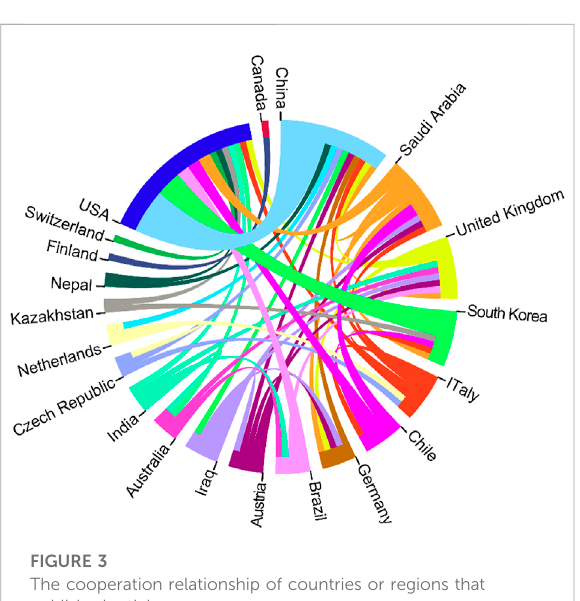
FIGURE 3 The cooperation relationship of countries or regions that published